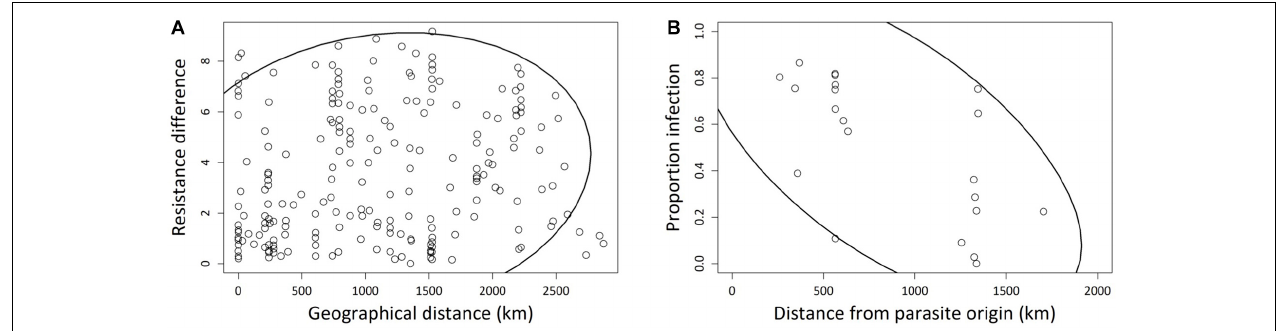
FIGURE 4 | (A) Correlation between pairwise geographic Euclidean distances and pairwise resistance differences, for 21 European Paramecium caudatum strains inoculated with the parasite Holospora undulata . Resistance differences based on the mean residual infection prevalences for each strain, after statistically correcting for laboratory and experimental block effects. Absolute values of pairwise differences were used for the correlation analysis. Each point refers to a different pair of strains. (B) Correlation between infection prevalence and the geographic distance between the origin of a given P. caudatum strain and the origin of parasite tester isolate. Infection prevalence was averaged over multiple replicates per strain. Each point represents one strain. The 90% density ellipsoids represent a graphical indicator of the correlation between the two variables in each